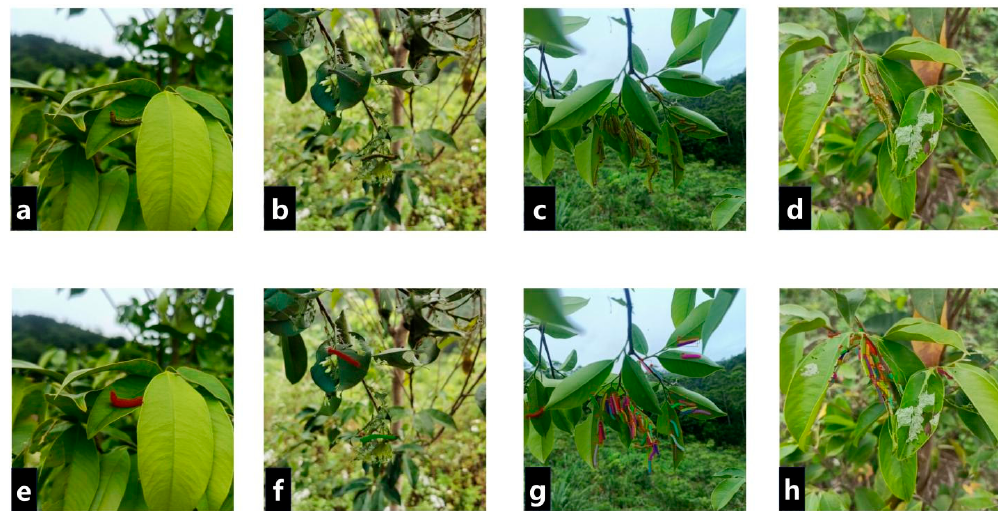
Figure 1. Examples of captured images and the corresponding annotation. ( a ) Single larva of Heortia vitessoides affected by shadows; ( b ) Multiple larvae of Heortia vitessoides affected by uneven color on the surface; ( c ) Multiple clustering larvae of Heortia vitessoides affected by shadows and occlusion; ( d ) Multiple clustering larvae of Heortia vitessoides impacted by uneven color on the surface, occlusion, and shadow; ( e ) Annotation of ( a ); ( f ) Annotation of ( b ); ( g ) Annotation of ( c ); ( h ) Annotation of ( d ).